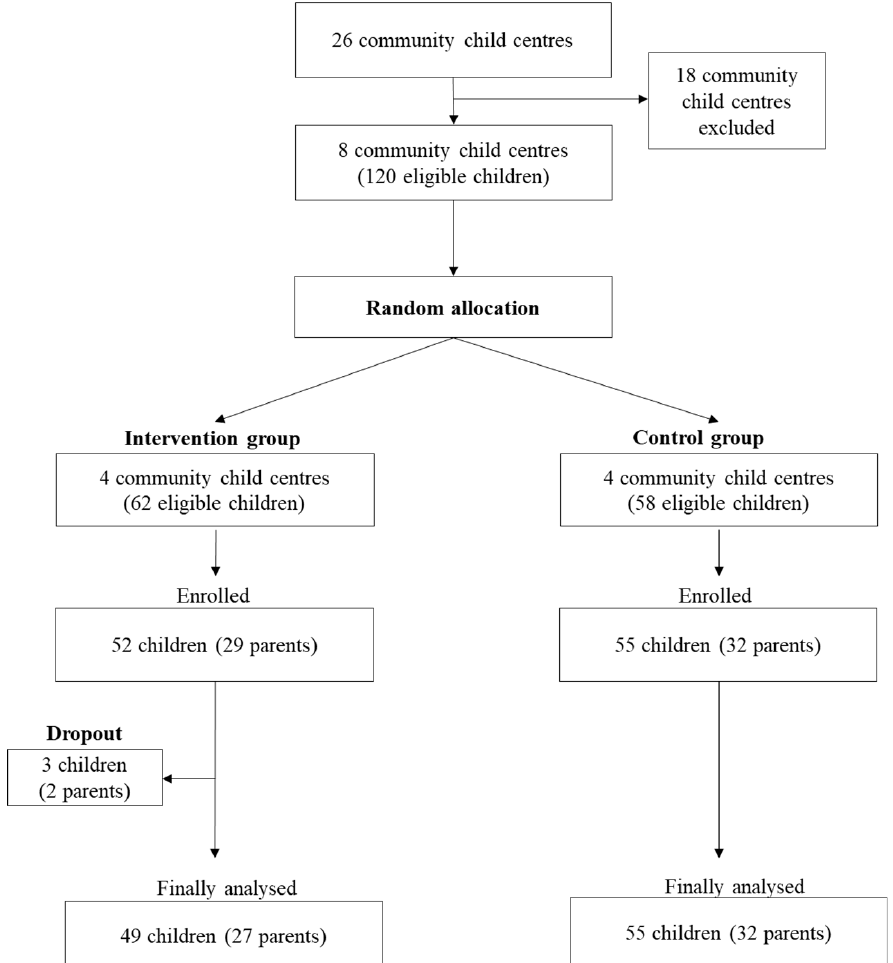
Figure 1. Participants’ flow chart.